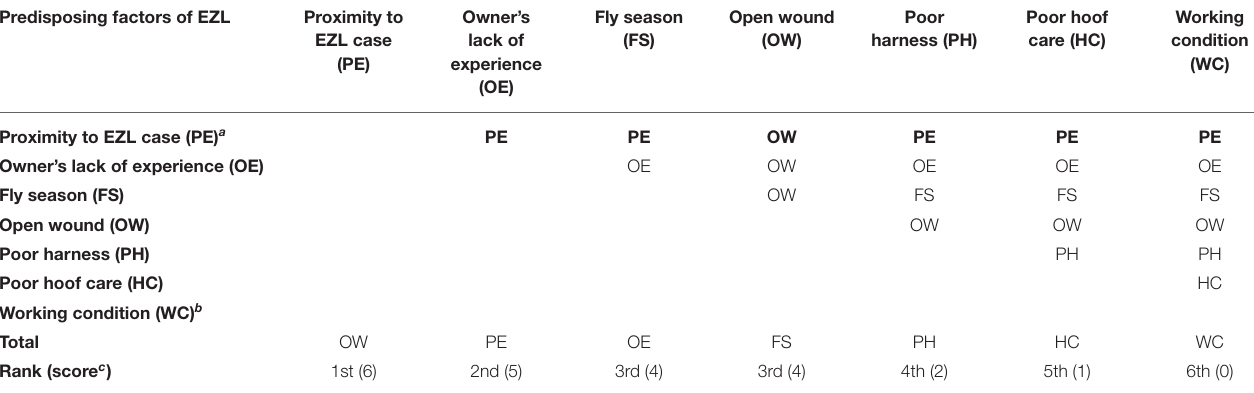
TABLE 5 | Pairwise ranking of the predisposing factors identified by experienced muleteers during focused group discussions. Predisposing factors of